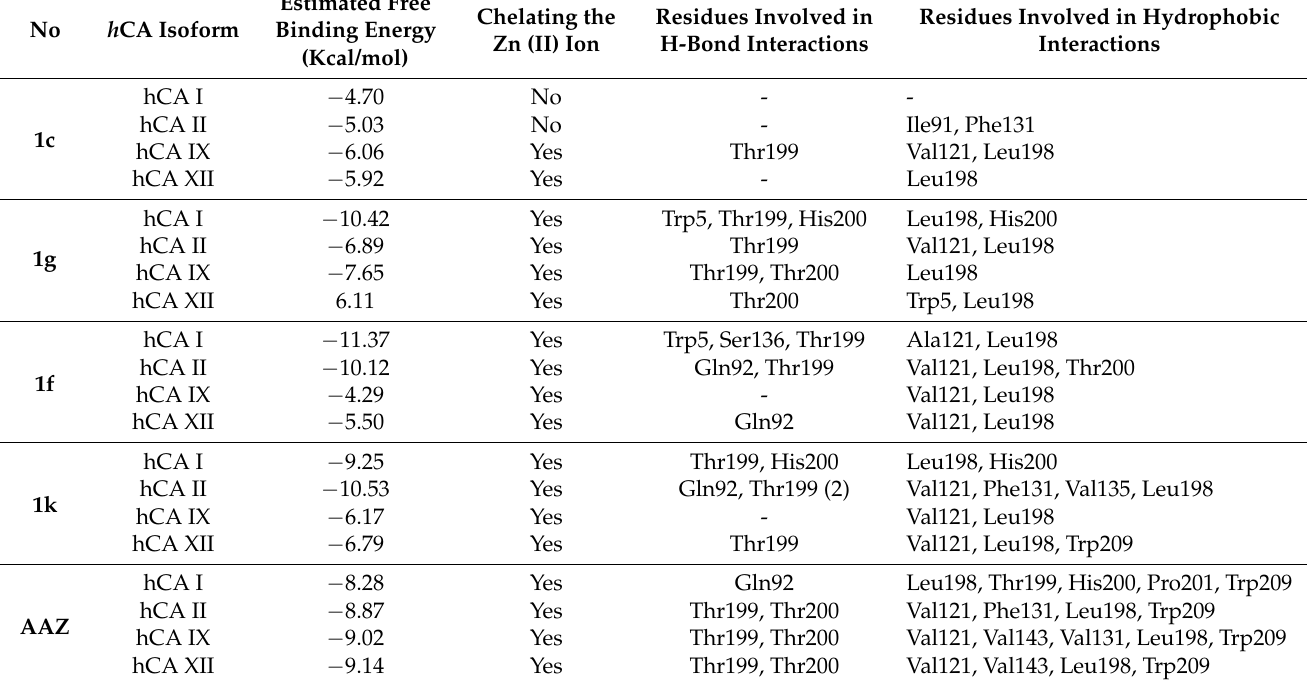
Table 4. Molecular docking free binding energies (kcal/mol) and interactions of tested compounds on hCA I, II, IX, and XII